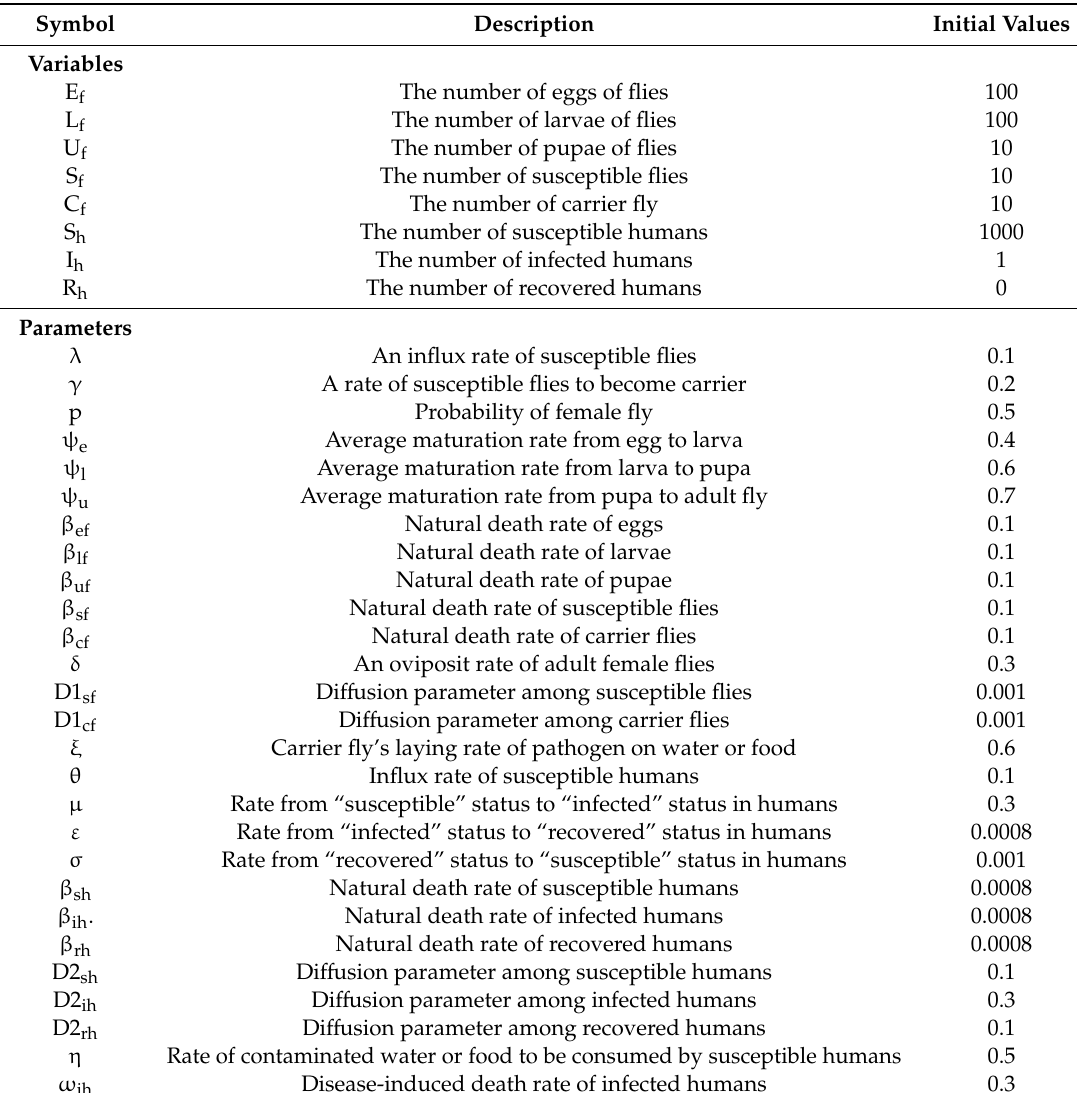
Table 1. Notations of variables and parameters.